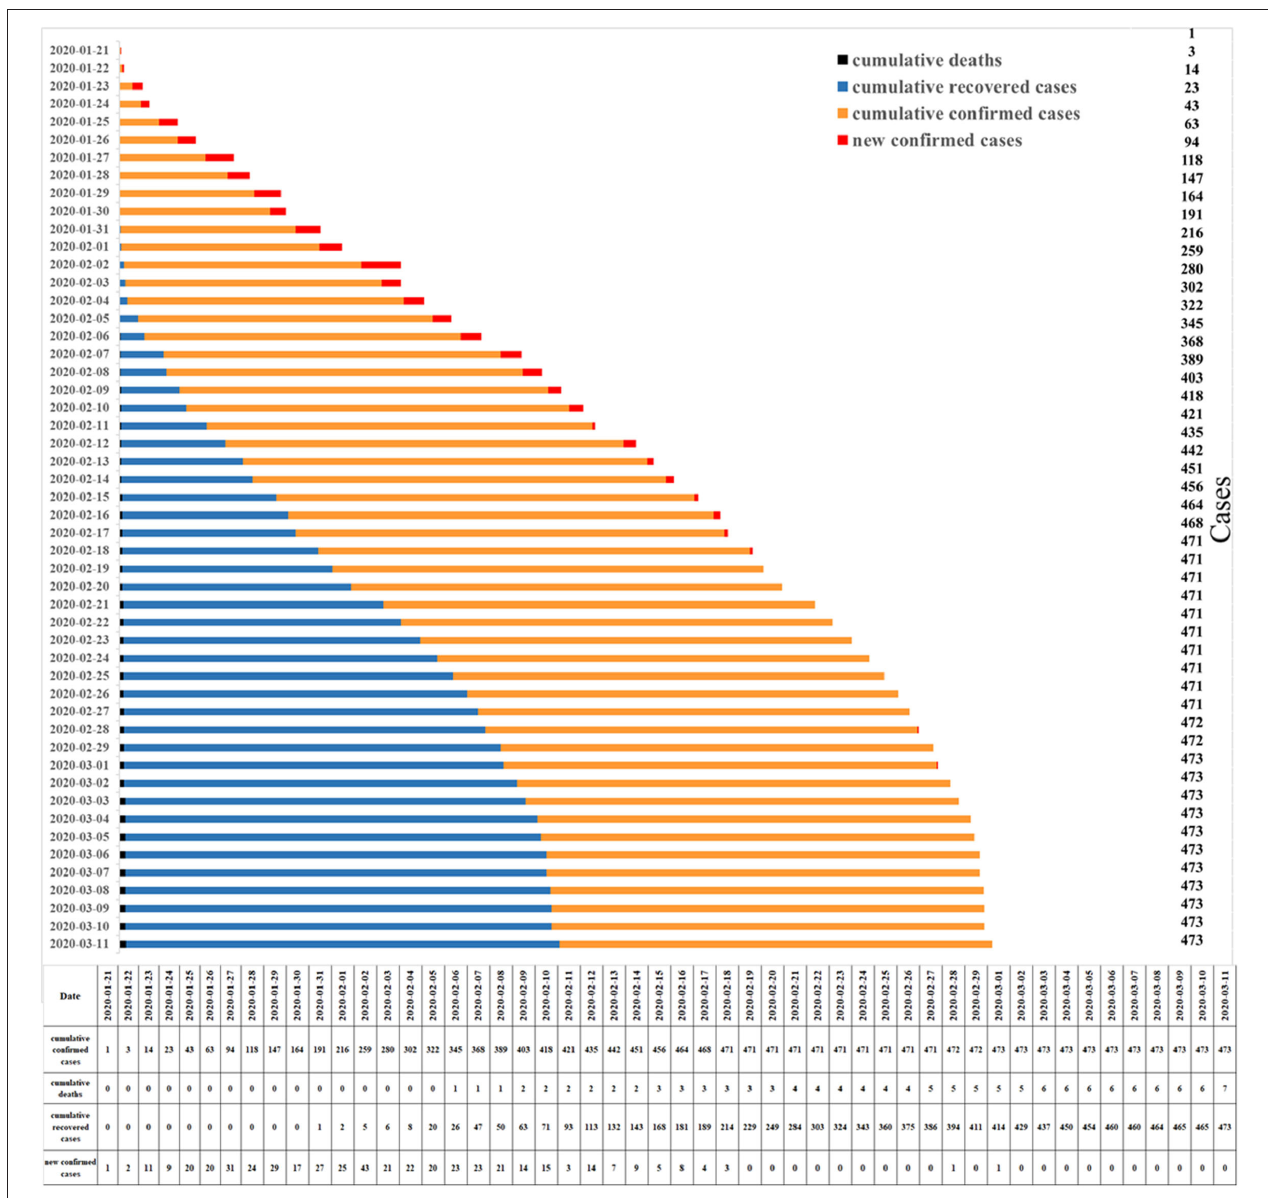
FIGURE 3 | Time distribution of cumulative cases in Northwestern China through March 11th,